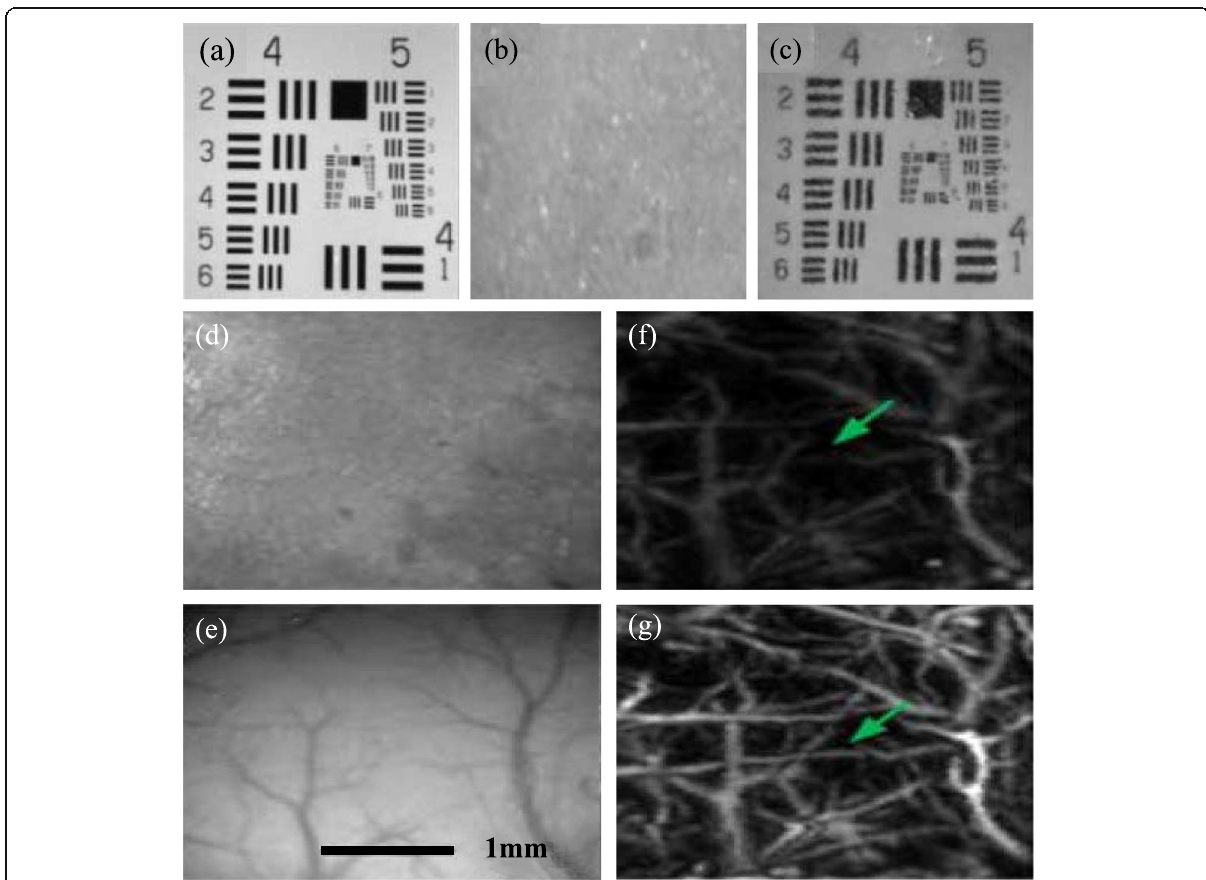
Fig. 4 The effect of SOCS on the skull in vitro and in vivo [61]. a - c Typical reflected images of the USAF target without and with the skull, and with SOCS-treated skull, respectively. Typical reflection images of cortical blood vessels obtained from untreated skull d and from the transparent skull after SOCS treatment for 25mins e . Photoacoustic images obtained from intact skull f and from the transparent skull after SOCS treatment for 25 mins